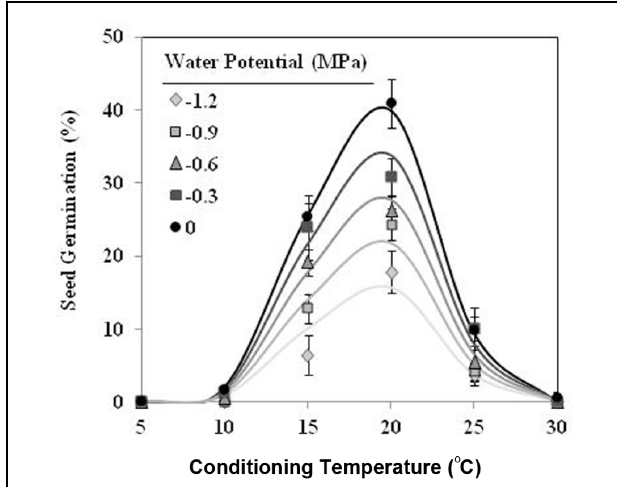
FIGURE 1 | Effects of temperature ( ◦ C) and water potential (MPa) on seed germination of Orobanche crenata during conditioning period. The lines were fitted according to Analysis β equation (Hau and Kranz, 1990; Table 1 ). Points represent the average of 12 repetitions. Bars represent the SD of the mean.